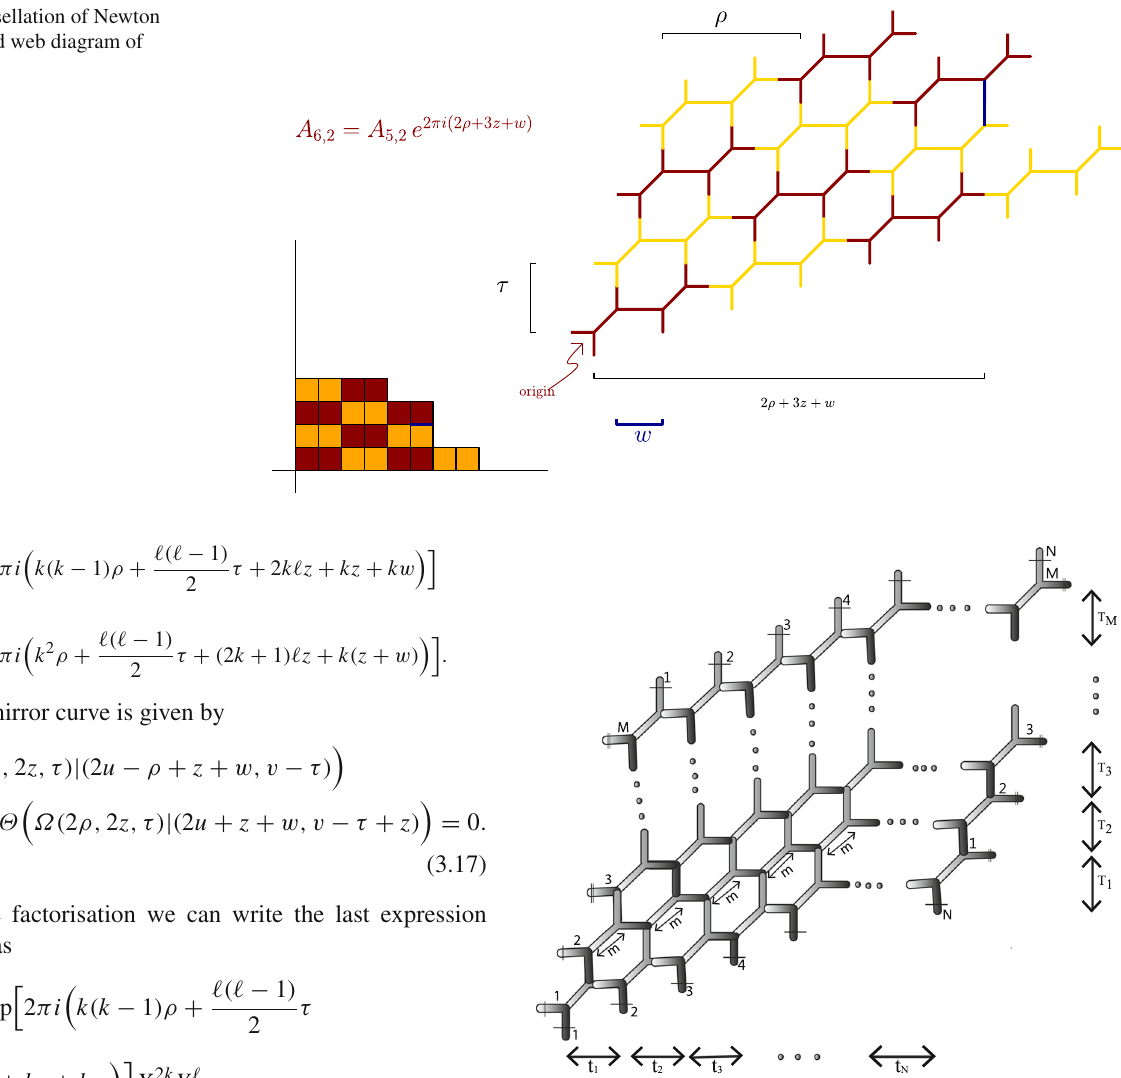
Fig. 5 Web diagram of X N , M . t i ∈ { t 1 ,..., t N } denotes the distance between i -th and i + 1-th vertical lines and T i ∈ { T 1 ,..., T M } denotes thedistancebetween i -thand i + 1-thhorizontallines. m a , b parametrize the diagonal P 1 s